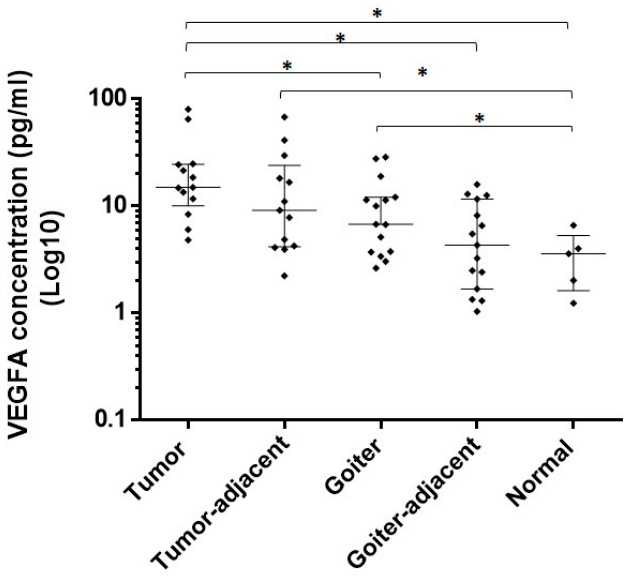
Figure3. ProteinexpressionofVEGFAintumor, goiter, andnormaltissuesamples. VEGFAconcentration was Log10 transformed ( y -axis). Mann–Whitney test (* p Figure 3. Protein expression of VEGFA in tumor, goiter, and normal tissue samples. VEGFA concentration was Log10 transformed ( y ‐ axis). Mann–Whitney test (* p value).